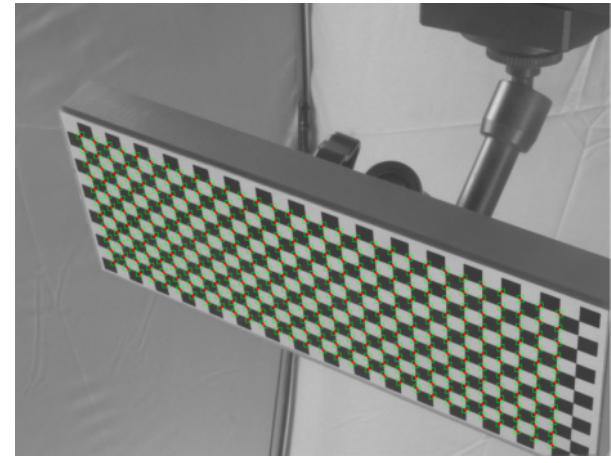
Figure 3. Corner points detected by Harris corner detection algorithm. In most cases, the iterative accuracy of 0.005 pixels can be achieved after two or three iterations. The iterative process is shown in Figure 4.